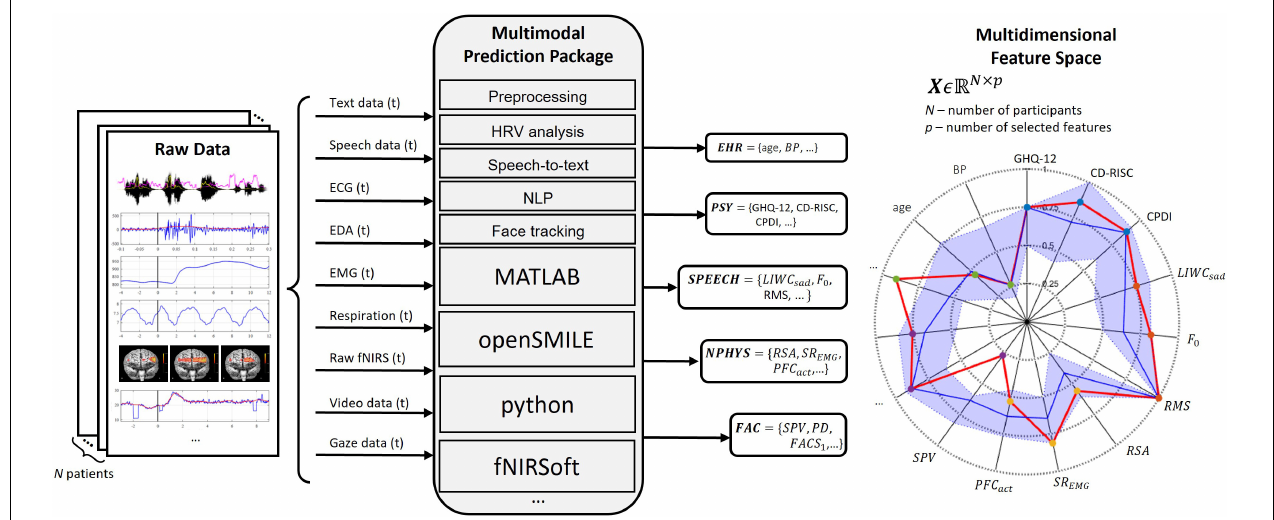
FIGURE 2 | Multimodal data acquisition as input for real-time and offline feature computation. Illustrated subset of selected features includes: General Health Questionnaire (GHQ-12), Connor-Davidson Resilience Scale (CD-RISC), COVID-19 Peritraumatic Distress Index (CPDI); NLP feature LIWC “sad,” voice fundamental frequency (F 0 ), voice root mean square (RMS); respiratory sinus arrhythmia (RSA), EMG-based startle reactivity (SR EMG ), prefrontal cortex activity (PFC act ); saccadic peak velocity (SPV), pupil dilation (PD), a feature related to facial action coding system